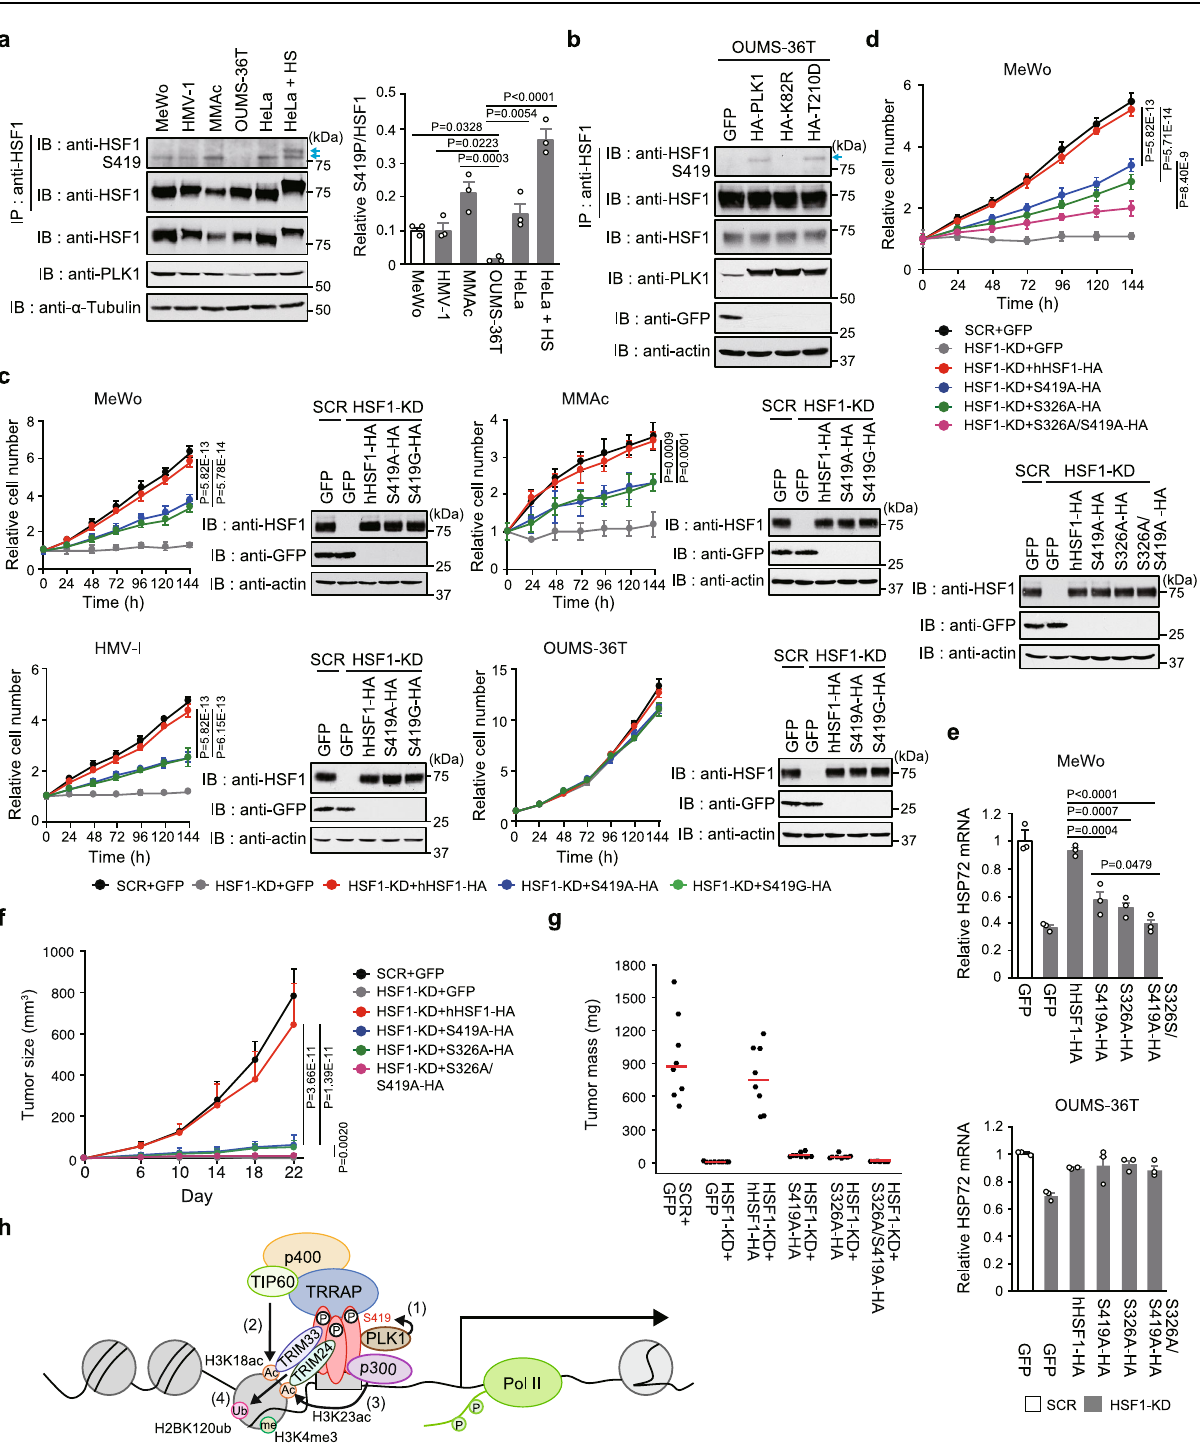
Fig. 7 | HSF1 phosphorylation supports tumor formation. a Equal amounts of total cellextracts from melanoma celllines, HeLa cells (controland heat-shocked), and OUMS-36T-3F cells were subjected to HSF1 immunoprecipitation and immu- noblotting. Relative levels of HSF1-S419 phosphorylation normalized by HSF1 protein levels are shown. b Phosphorylation of HSF1-S419 is induced by over- expression of PLK1 in OUMS-36T-3F cells. HSF1 immunoprecipitation and immu- noblotting were performed as described in Fig. 5a. c, d Endogenous HSF1 was replacedwithGFP,hHSF1-HA,S419A-HA,S419G-HA( c , d ),orS326A/S419A-HA( d )in melanoma and OUMS-36T-3F cells. Cell extracts were subjected to immunoblot- ting. e MeWo and OUMS-36T-3Fcellswere treated as describedin d . HSP72 mRNA levels were quanti fi ed and shown. f , g Tumor sizes and masses of melanoma cells